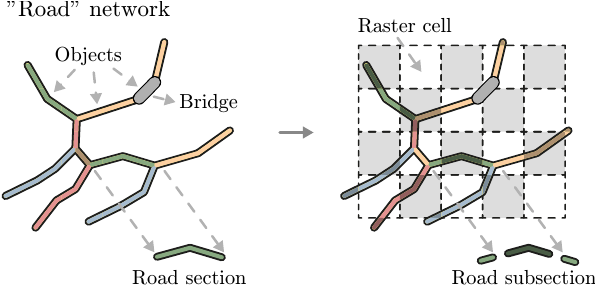
Figure 3. The road network consists of numerous objects. The ob- jects considered are bridges and road sections, which are mapped as edges in the network. Given spatial considerations during the risk assessment, the road sections are divided into subsections. The length of subsections is defined by a projected raster grid matching the grid of the hazard